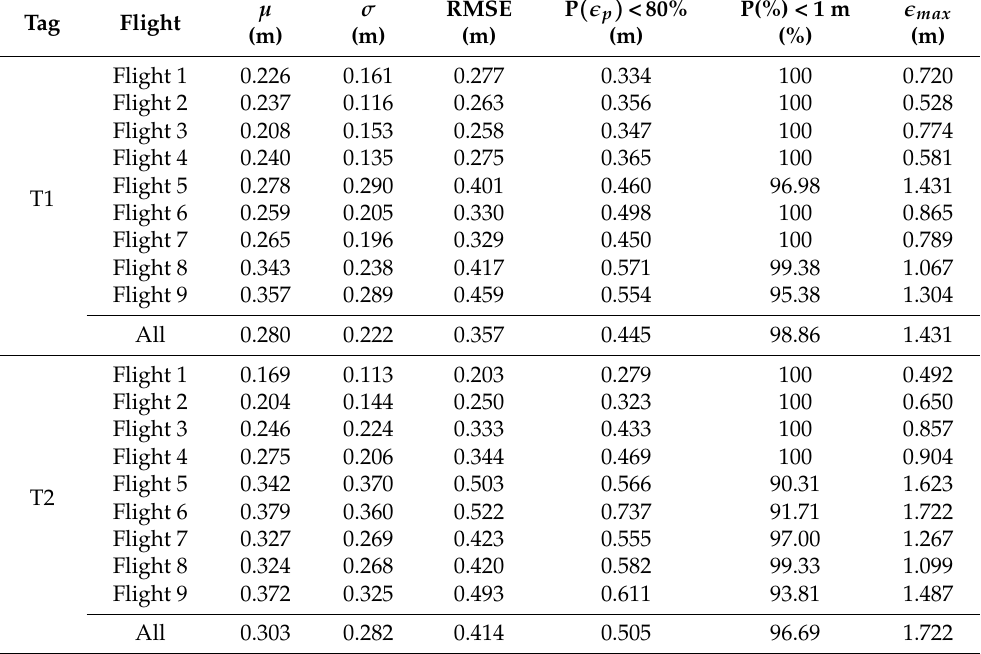
Table 6. Accuracy using only UWB data with eight anchors.